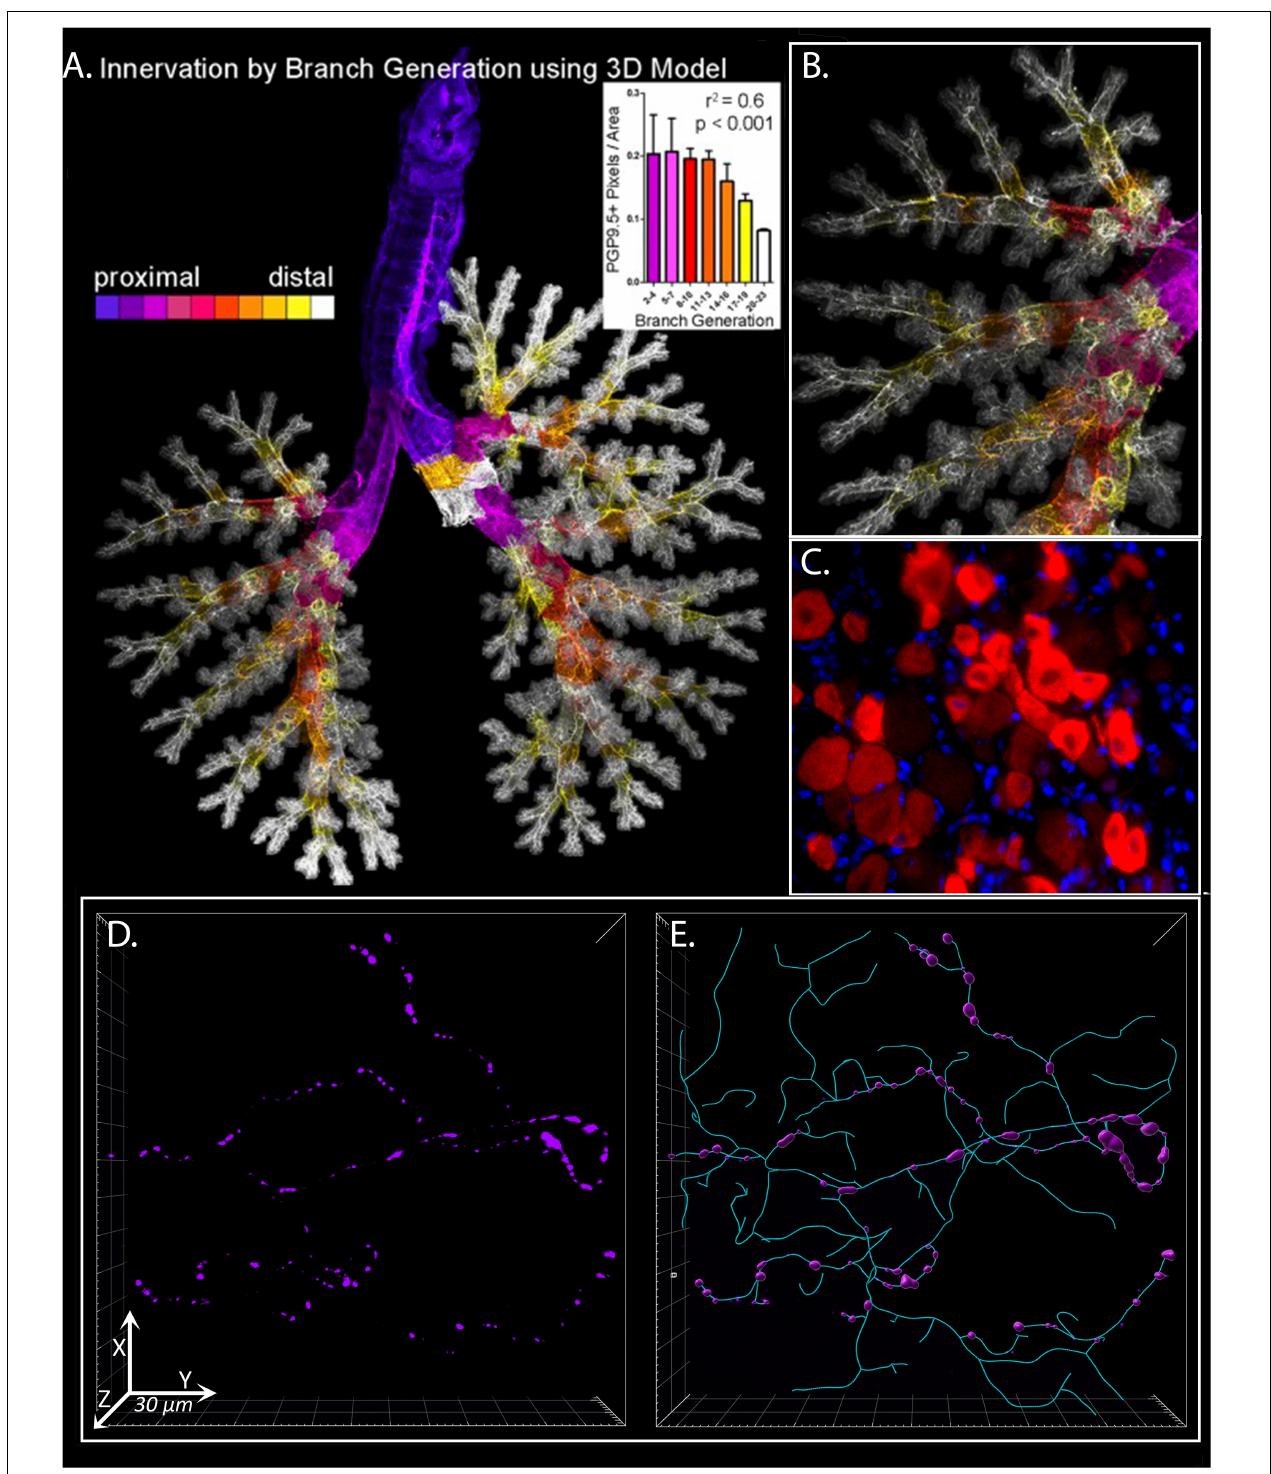
FIGURE 1 | 3D Analysis of Sensory Innervation of the Lung. Mouse and human airway nerves are labeled and imaged using immunofluorescence and confocal microscopy. (A) Flattened image of mouse lungs with nerves identified using antibodies against the pan-neuronal protein PGP9.5. Color-coding is based on airway generation from proximal ( purple ) to distal ( white ). Nerve density in each generation was calculated ( inset ). (B) Higher magnification image of airway shown in (A) . (C) Mouse vagal ganglion with purinergic P2X3 receptor expression in red. (D) Human airway neuronal substance P expression (purple) in bronchoscopic